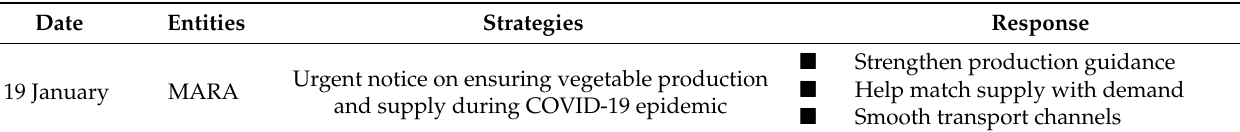
Table 1. China’s strategies and response towards for sustainable food processing industry during